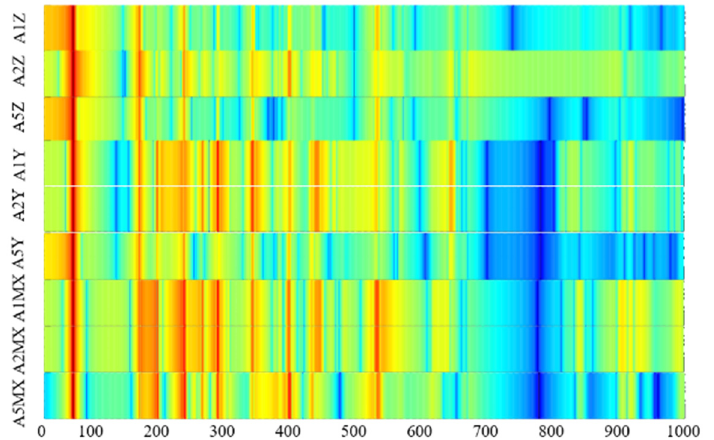
Figure 13. Vibration power flow transfer path analysis of P2.